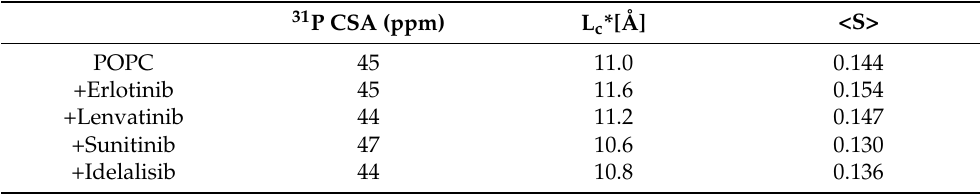
Table 1. The 31 P NMR chemical shift anisotropy (CSA), the average 2 H NMR order parameter <S>, and the calculated chain length L C * of the POPC sn-1 acyl chain for pure POPC- d 31 and for POPC- d 31 in the presence of the respective inhibitor.